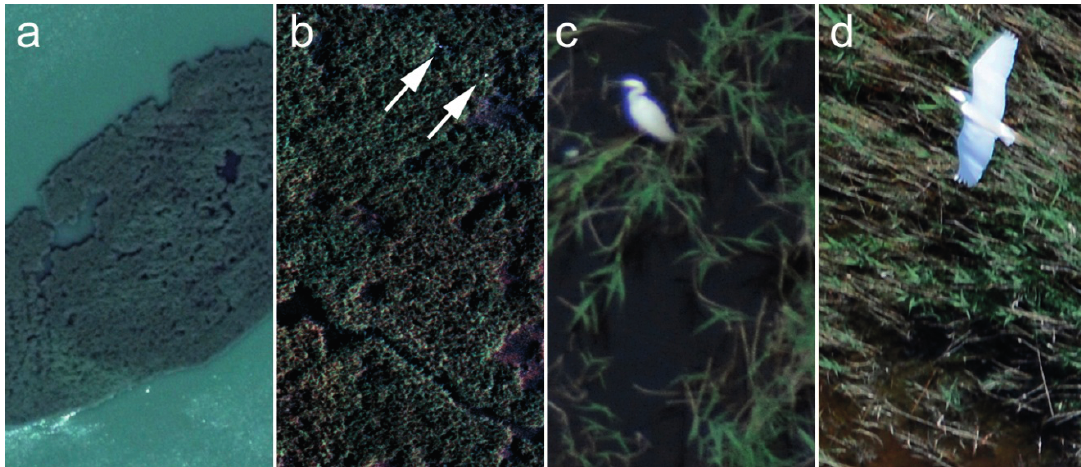
Figure 5. Full resolution details of the sample area: ( a ) satellite image in Google Earth with a 50 cm spatial resolution; ( b ) 10 cm spatial resolution orthophoto section photographed on Kodak film where the arrows indicate two white spots that are possibly flying birds. The 0.5 cm spatial resolution ortho image section recorded by the Interspect calibrated aerial camera of ( c ) a standing heron; and ( d ) a flying